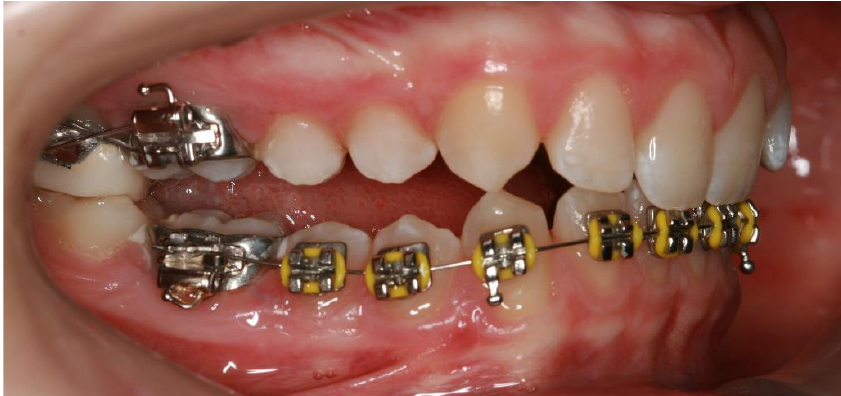
Figure 3. The fixed sagittal guidance (FSG) and fixed orthodontic (SWA) appliance.